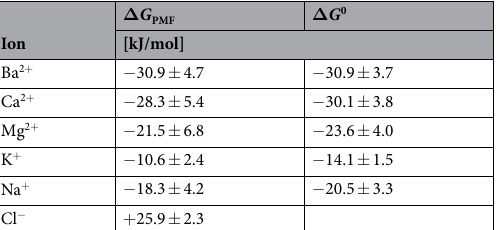
Table 1. Free energies for the different ion types. The deepest PMF well ( − ) or highest barrier ( + ) for each ion type is given by Δ G PMF . Δ G 0 is the derived standard free energy of